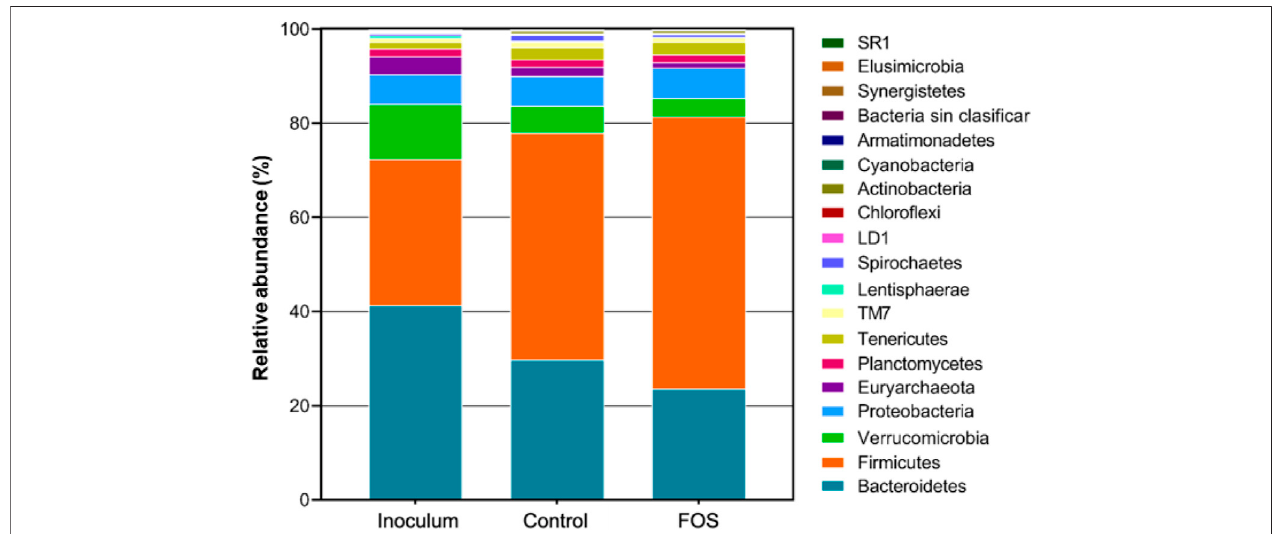
FIGURE 3 | Microbiota pro fi les at the phylum level representing bacterial and archaea of the following treatments: inoculum, control, and supplemented with fermented oat straw (Lv concentration of 150 mg L − 1